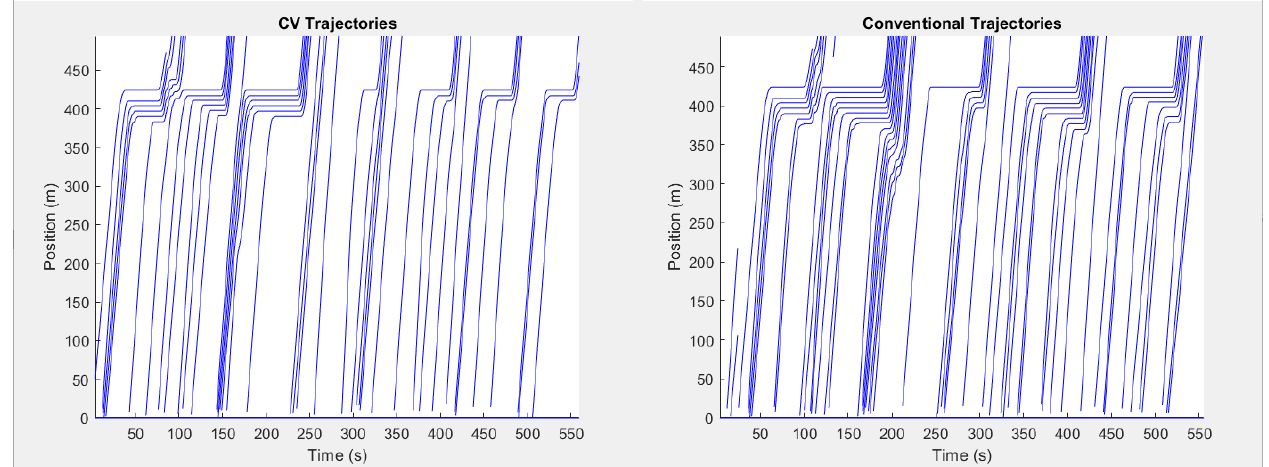
Figure 10. Side-by-side comparison of space-time diagrams for the Westbound Approach on 72nd Avenue (132nd Street and 72nd Avenue) (stop line at x = 425 m).